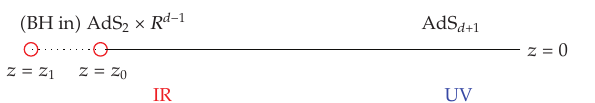
Figure 18: The geometry of the near-extremal AdS d (cid:8) 1 charged black hole for T (cid:25) μ